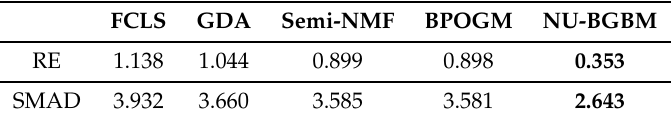
Table 3. Comparison of REs ( × 10 − 2 ) and SMADs ( × 10 − 2 ) of different methods using extracted endmembers for the gulf of lion real HSI.